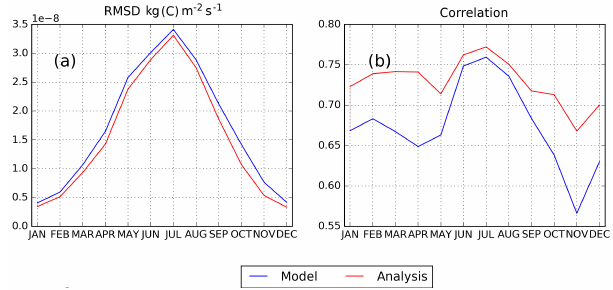
Figure 15. Seasonal (a) RMSD and (b) correlation values between the Carbon mass flux out of the atmosphere due to Gross Primary Production on land from the open loop, analysis and FLUXNET- MTE estimates over